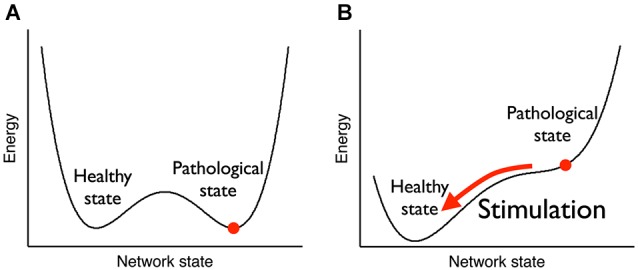
Attractor landscape pre-post therapeutic stimulation. (A) Before stimulation, both the pathological state (strong weights, high neuronal synchronization) and the healthy state (weak weights, low neuronal synchronization) are stable, i.e., they are local minima of an abstract energy function. (B) During stimulation, the pathological state becomes unstable and the network is driven towards the healthy state. After stimulation has stopped, the network stays in the healthy state. From Pfister and Tass (2010).